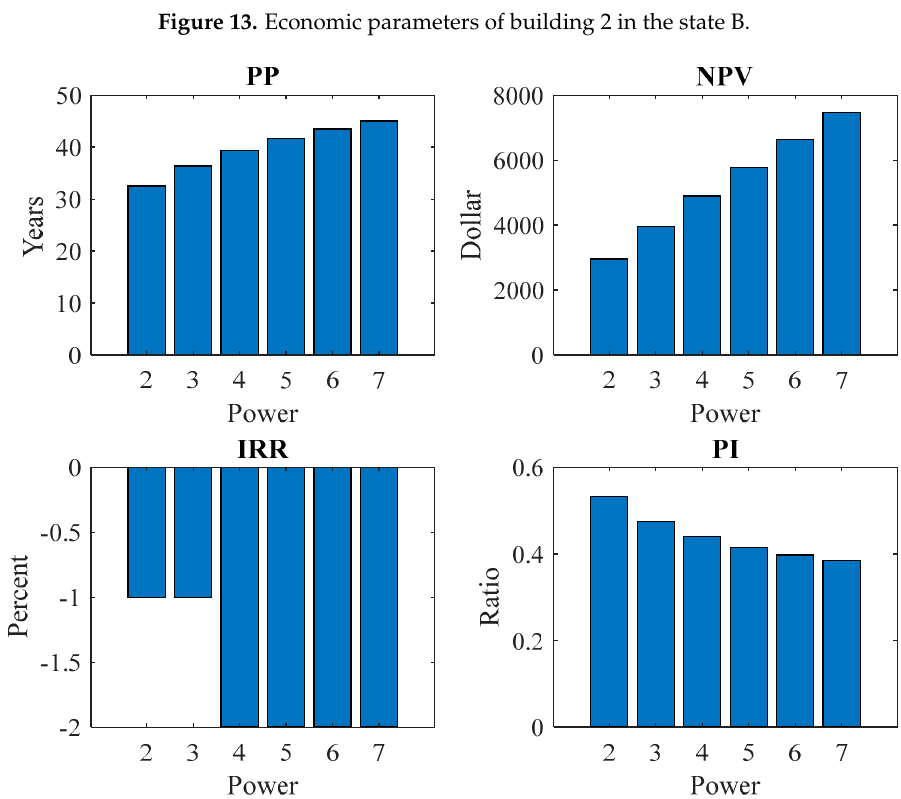
Figure 14. Economic parameters of building 3 in the state B.